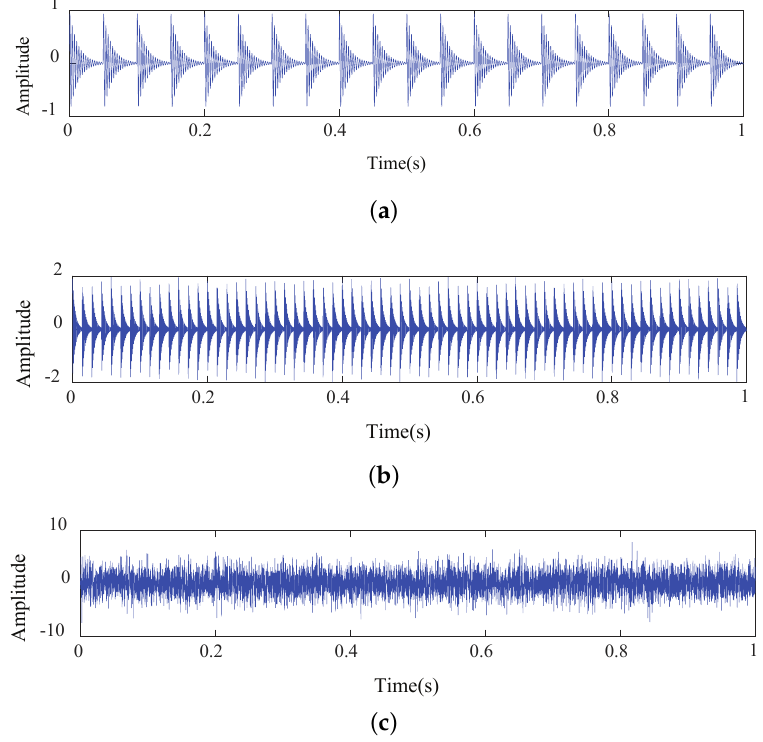
Figure 4. Simulated signal: ( a ) s 1 ( t ) . ( b ) s 2 ( t ) . ( c ) s ( t )